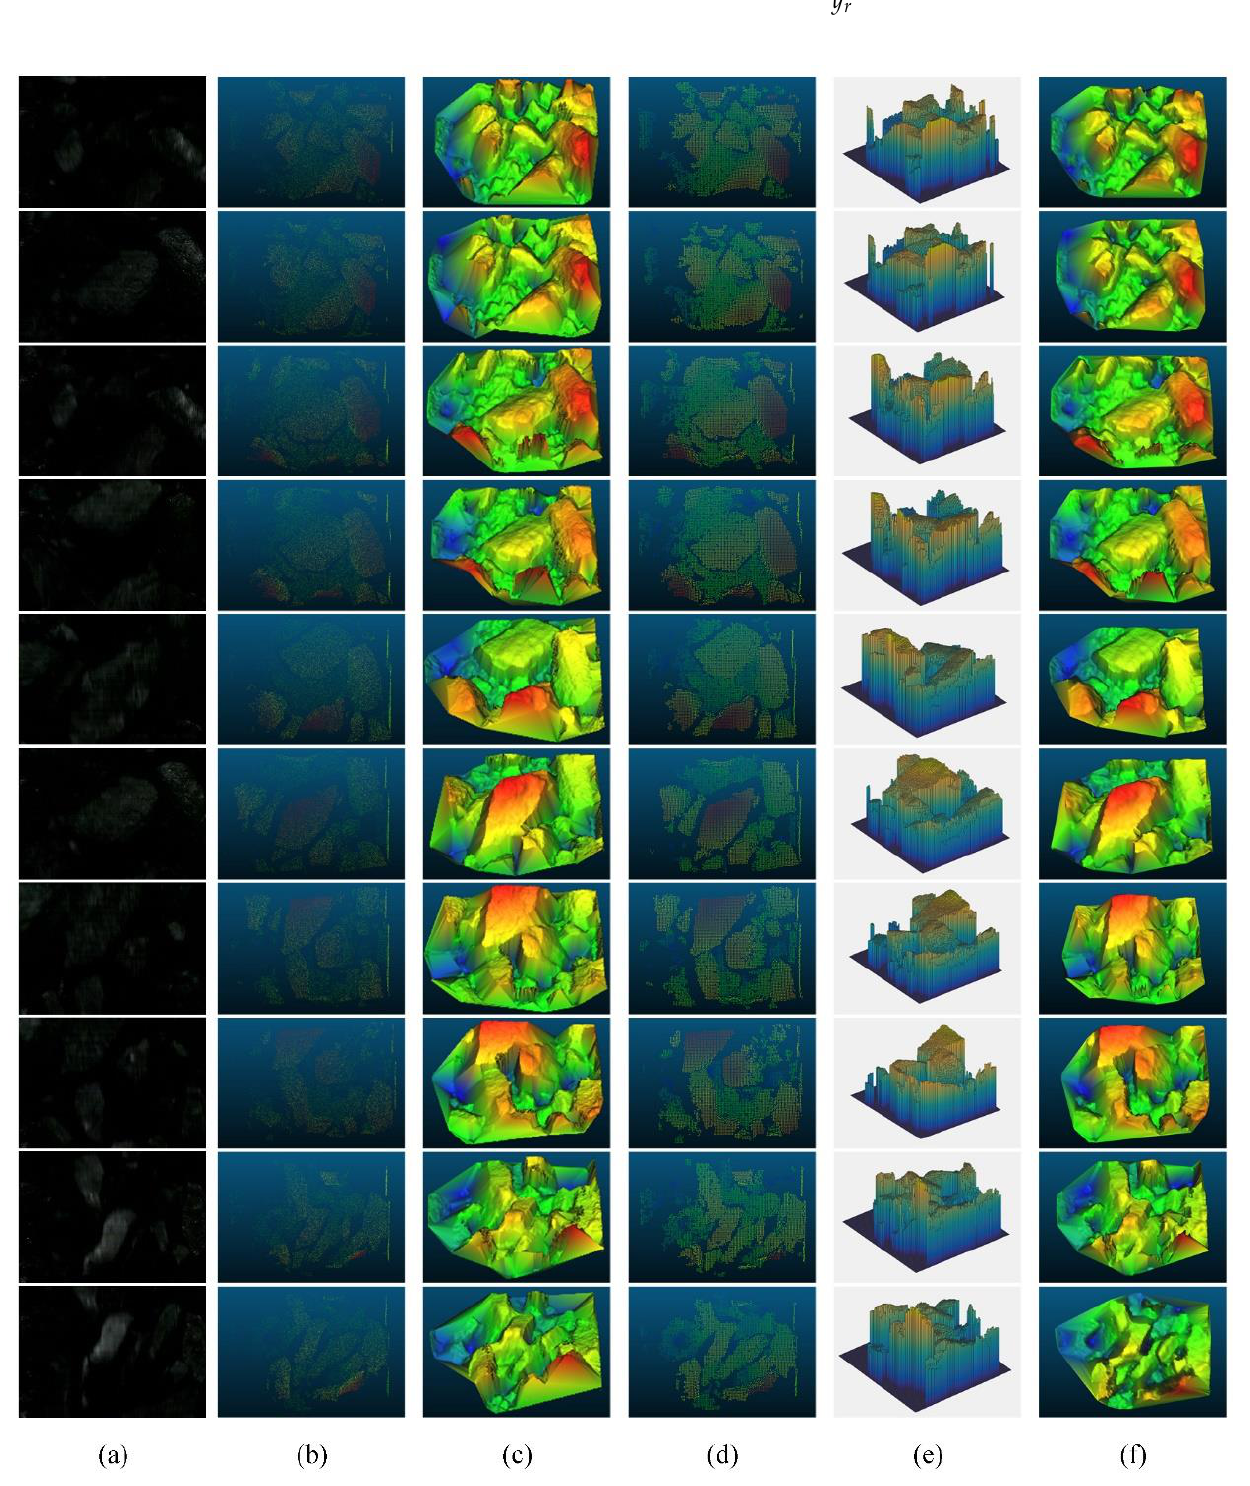
Figure 13. Original and simplified models: ( a ) Image; ( b ) Raw point cloud; ( c ) Original model; ( d ) Simplified point cloud; ( e ) Computational model; ( f ) Simplified model.